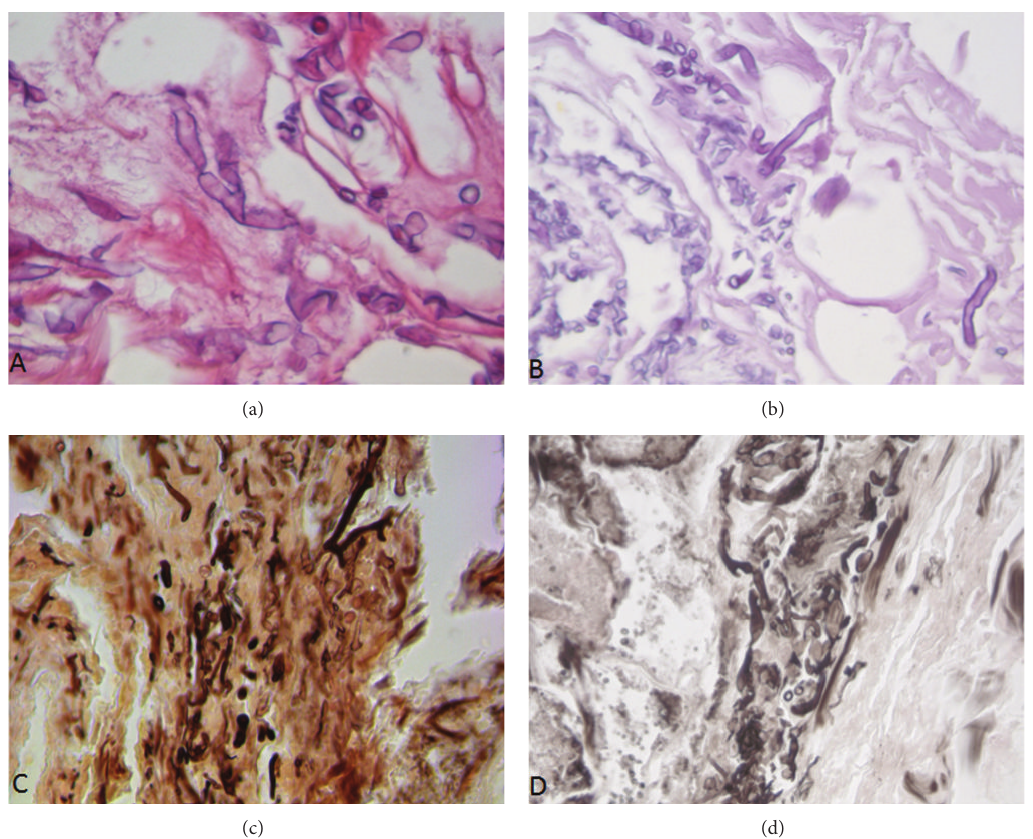
Figure 2: Spores and broad, stubby, irregularly-shaped hyphae, in many cases with nondichotomous right-angle branching; (a) hematoxylin- eosin staining, (b) PAS staining, and (c)-(d) Gomori silver methenamine staining; original magnification = 400x.